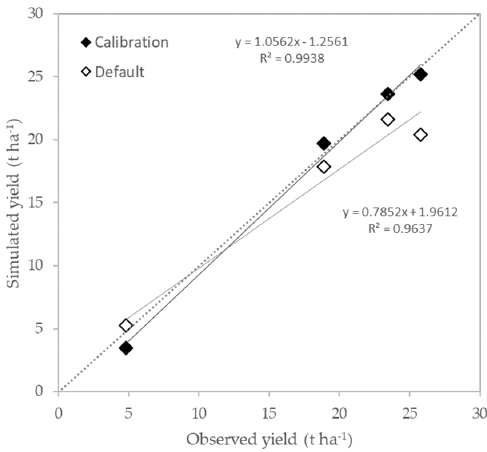
Figure 3. Simulated versus observed dry root yield at harvest for the AIMCRA experiment used for model calibration with the calibrated and default crop parameters.